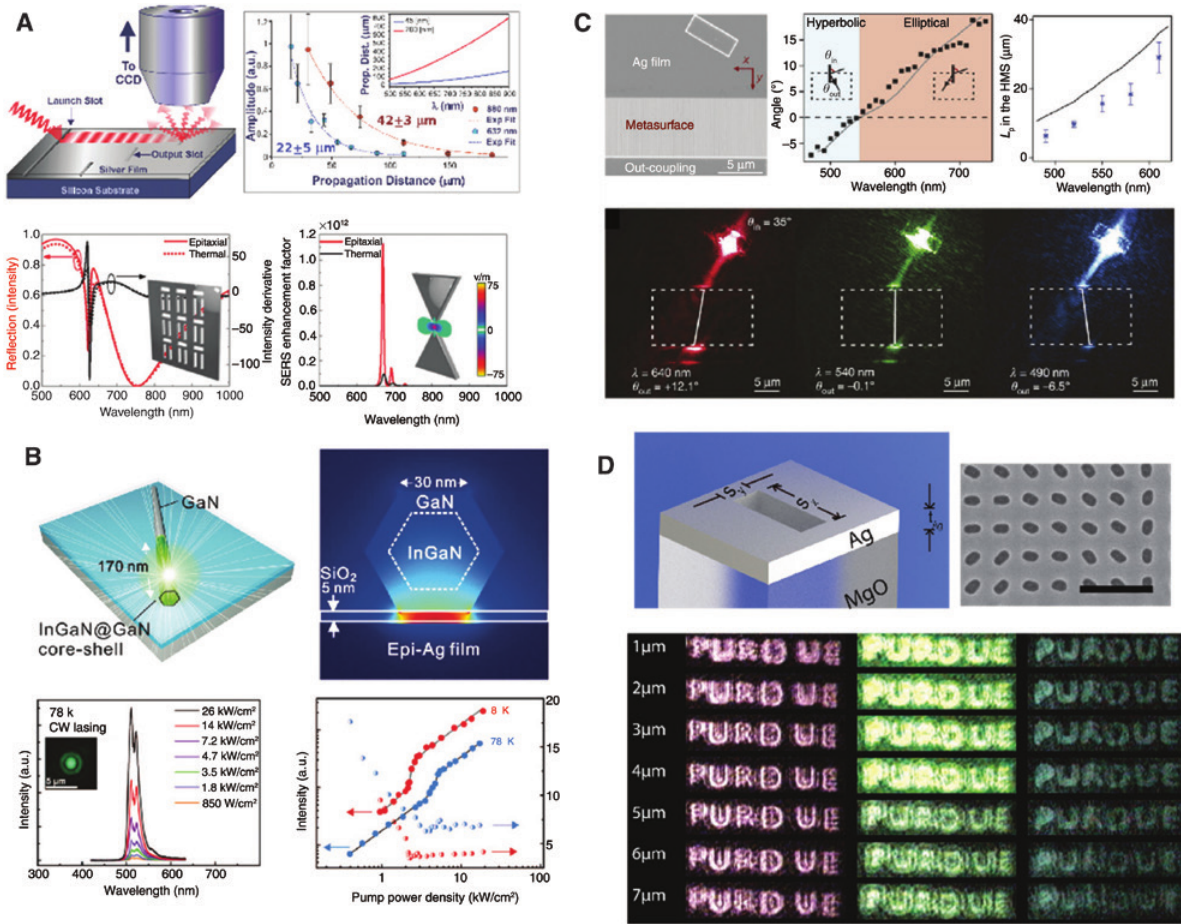
Figure 3: Epitaxial silver for metasurface applications. (A) Epitaxial silver shows sharper Fano resonance or enhanced field confinement in bow-tie antenna compared to their evaporated counter- parts [136]. Top-left panel shows experimental setup with SPP waves launched in the silver thin film. Top-right panel shows the propaga- tion distance for different amplitudes obtained experimentally. Bottom-left and bottom-right panels show the theoretical calculation for Fano-resonant and SERS enhancement factor for epitaxial and thermally evaporated silver. (B) Epitaxial silver mirror reduces mode volume of lasing [138]. The top-left panel shows the GaN-InGaN core-shell structure, and top-right shows the field enhancement in SiO layer with the epitaxial silver thin film. Bottom-left shows the emission spectra with different pump fluences and bottom-right shows the lasing saturation. (C) Hyperbolic dispersion in 2D structure demonstrated with the help of epitaxial silver [139]. Top-left panel shows the SEM image of the device, and the top-middle panel shows the deflection angle as a function of wavelength. Below 550 nm wavelength, the device shows negative refraction and therefore operates in the hyperbolic regime. Top-right panel shows the propagation length in the hyperbolic metasurface. The bottom panel shows optical images of the refraction in three different wavelengths of 640 nm, 540 nm, and 490 nm. (D) Color holography with epitaxial silver metasurface [40]. Top-left shows a schematic of a single unit cell, while top-right shows a SEM image, with scale bar representing 500 nm. The bottom panel shows optical images with objective focused at different distances from the metasurface. At 5 μ m distance, the image appears to be clearest. (A) Reprinted with permission from [136], copyright 2014 by John Wiley and Sons; (B) reprinted with permission from [138], copyright 2012 by the American Society for Advancement of Science; (C) reprinted with permission from [139], copyright 2015 by Springer Nature; (D) reprinted with permission from [40], copyright 2017 by John Wiley and